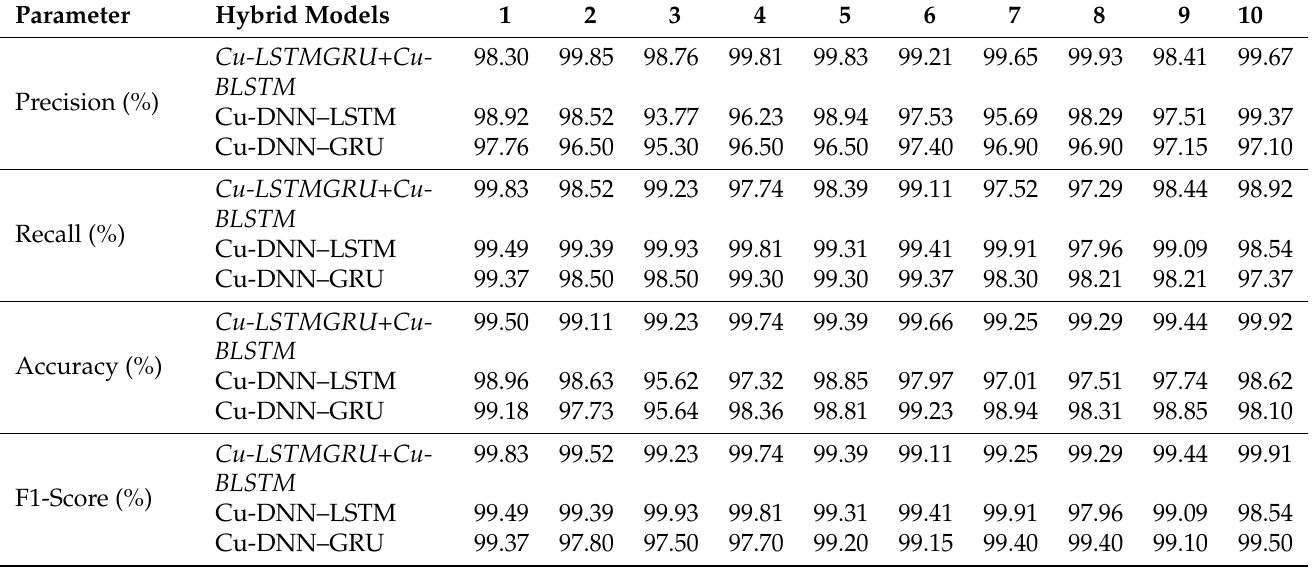
Table 5. 10-fold results of the hybrid models.